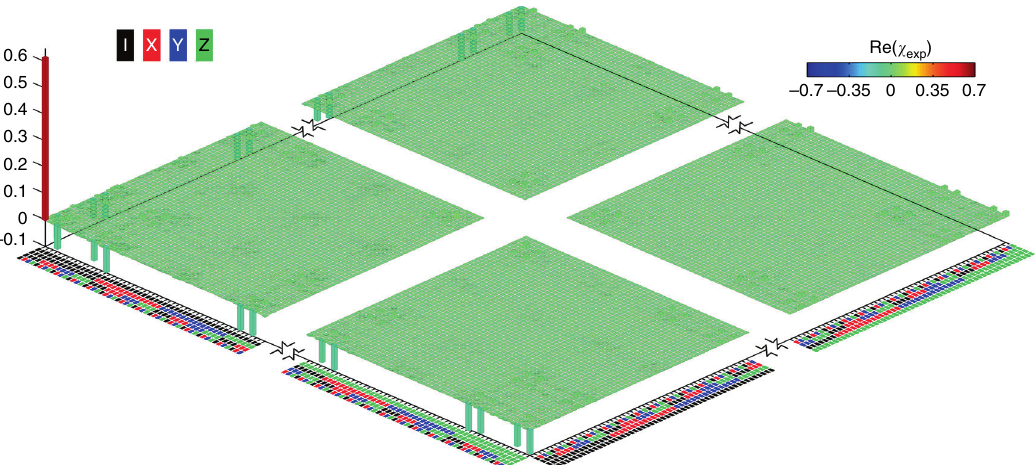
ffiffiffiffiffiffiffi p 6 : 9 MHz and detuning δ /2 π = 4 MHz. The color code for